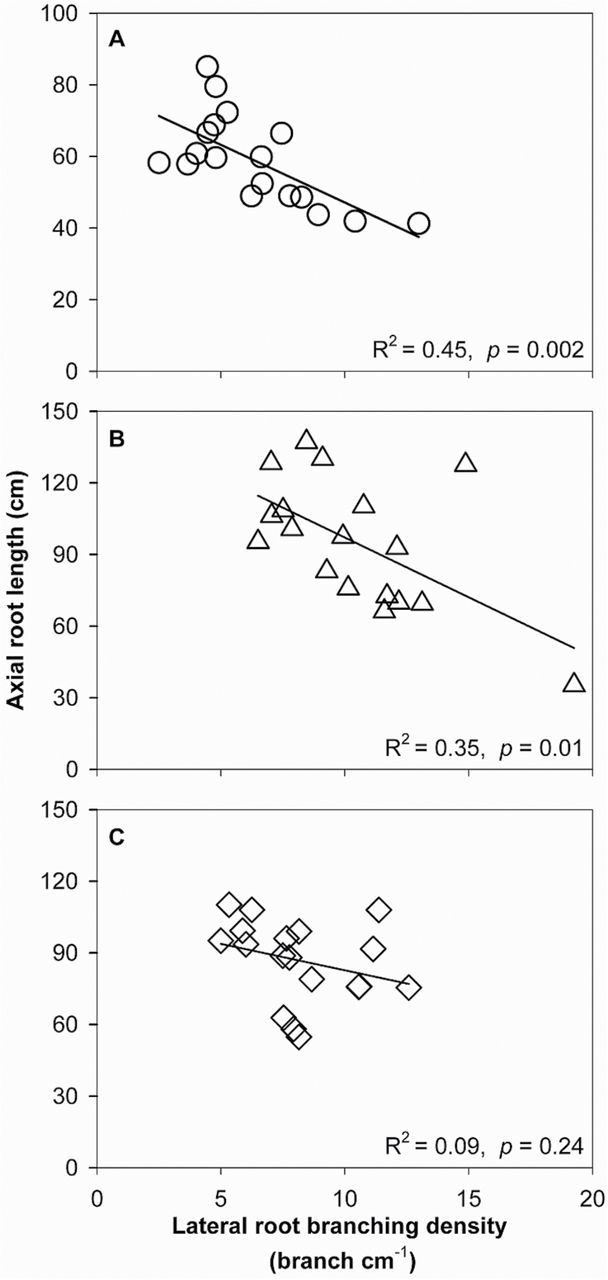
Correlation of axial root length with lateral root-branching density of crown roots (A), primary roots (B), and seminal roots (C) in GH mesocosms at 42 days after planting. Each point is the mean of four replicates of each genotype.